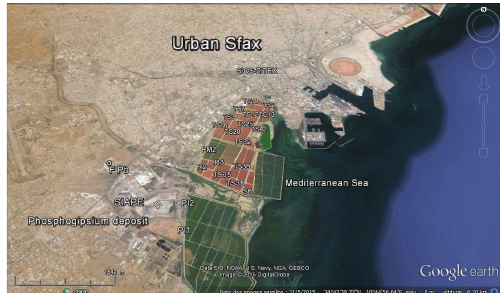
Figure 1: Map of the study area and sampling location in Sfax,